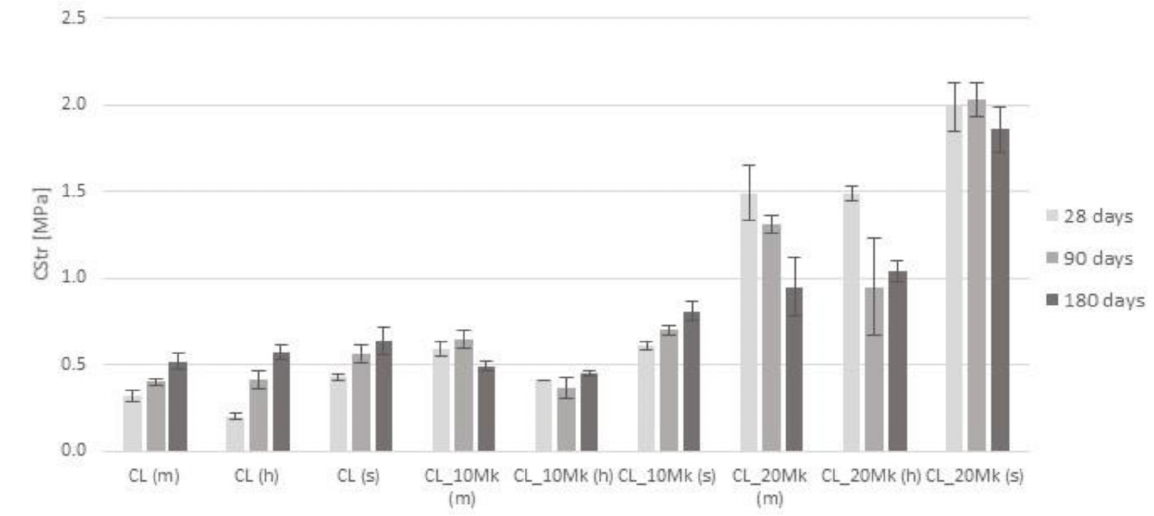
Figure 5. Compressive strength of mortars with 0, 10 and 20% Mk replacing air lime, after 28, 90 and 180 days in maritime, humid and standard curing